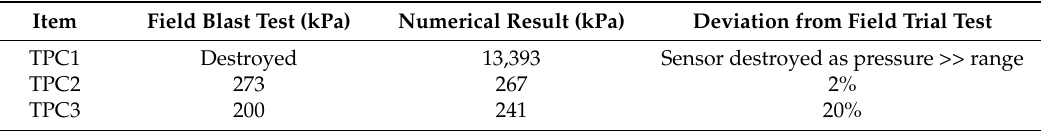
Table 8. Peak reading for the total pressure